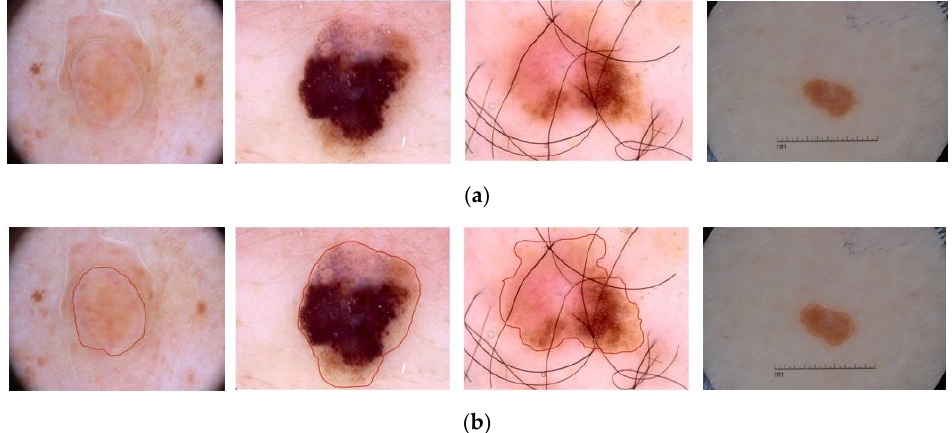
Figure 1. ( a ) Original dermoscopy images. ( b ) The red line area in the figure represents the lesion area of the corresponding image.